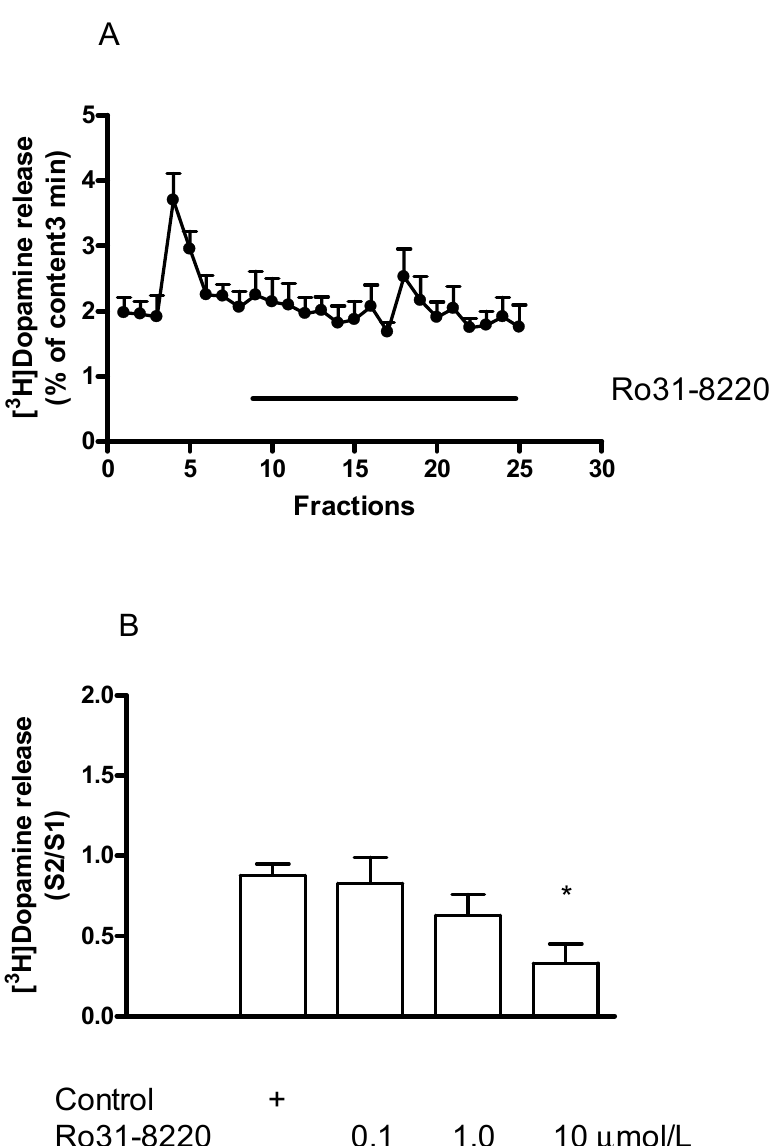
Figure 13. Effect of Ro31-8220 on [ 3 H]dopamine release from rat striatum. For the experimental procedure, see Figure 2A. ( A ) Filled circles indicate [ 3 H]dopamine release in the presence and absence of Ro31-8220. Ro31-8220 was added to striatal slices from fraction 8 in a concentration of 1 µ mol/L and maintained throughout the experiment. Resting release expressed by the B2/B1 ratio was 0.81 ± 0.03 in control and it was 0.90 ± 0.09 in the presence of Ro31-8220, the difference was not significant. The electrical stimulation-induced release expressed by the S2/S1 ratio was 0.80 ± 0.07 in control and it was 0.47 ± 0.10 in the presence of Ro31-8220, p < 0.05. Student t - statistics for two-means, mean ± S.E.M., n = 3-4. ( B ) Ro31-8220 concentration-dependently decreased electrical stimulation-induced [ 3 H]dopamine release from rat striatum. Ro31-8220 was added to striatal slices from fraction 8 in concentrations varied from 0.1 to 10 µ mol/L and maintained through the experiment. 10 µ mol/L Ro31-8220 reduced electrical stimulation-induced [ 3 H]dopamine release, * p < 0.01. One-way ANOVA followed by the Dunnett’s test, F(3,13) = 4.489, p = 0.022, mean ± S.E.M., n =